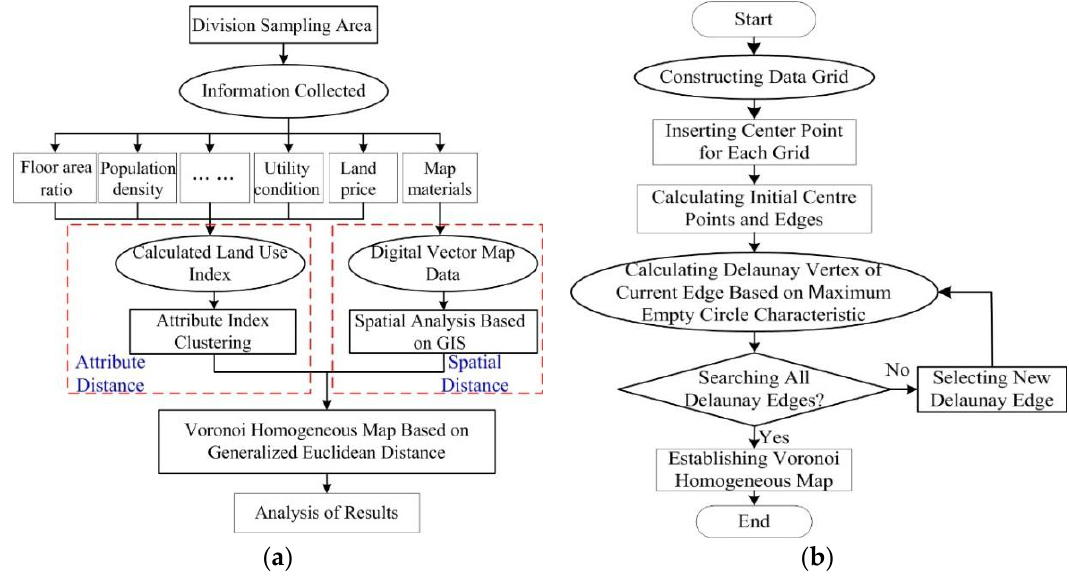
Figure 2. Research and Voronoi diagram flowcharts. ( a ) Technical flowchart used for the experiment; ( b ) Voronoi diagrams flowchart based on the C# program language and the Visual Studio 2010 platform. Table 2. Land use grid spatial and attribute